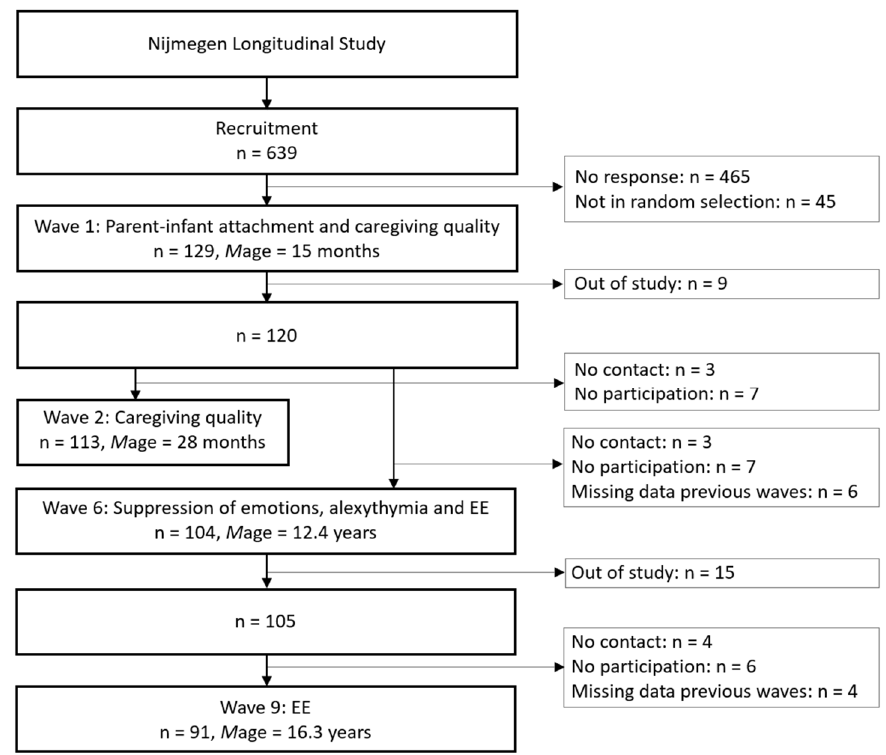
Figure 1. Nijmegen Longitudinal Study (NLS) flowchart.